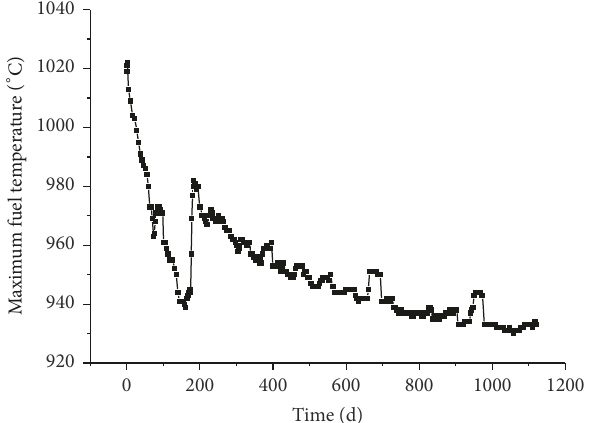
Figure 3: Maximum fuel temperature changing with time.